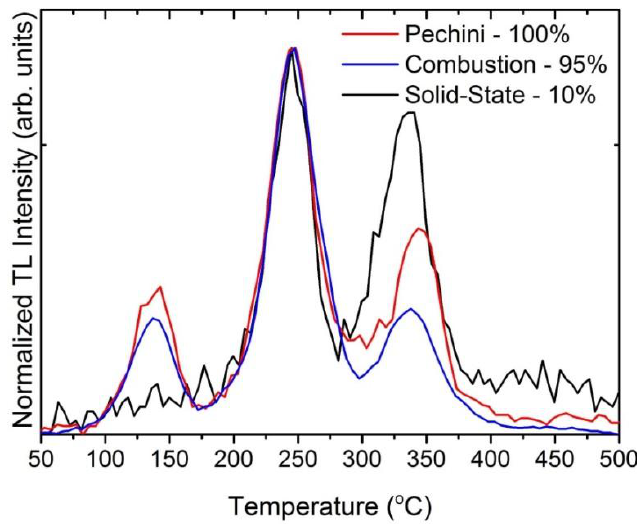
Figure 1. Thermoluminescence (TL) glow curves of Lu sintered at 1700  C in 25%H Pechini or combustion method or mixture of commercial oxides. The accuracy of the temperature for all TL experiments is ±2.5